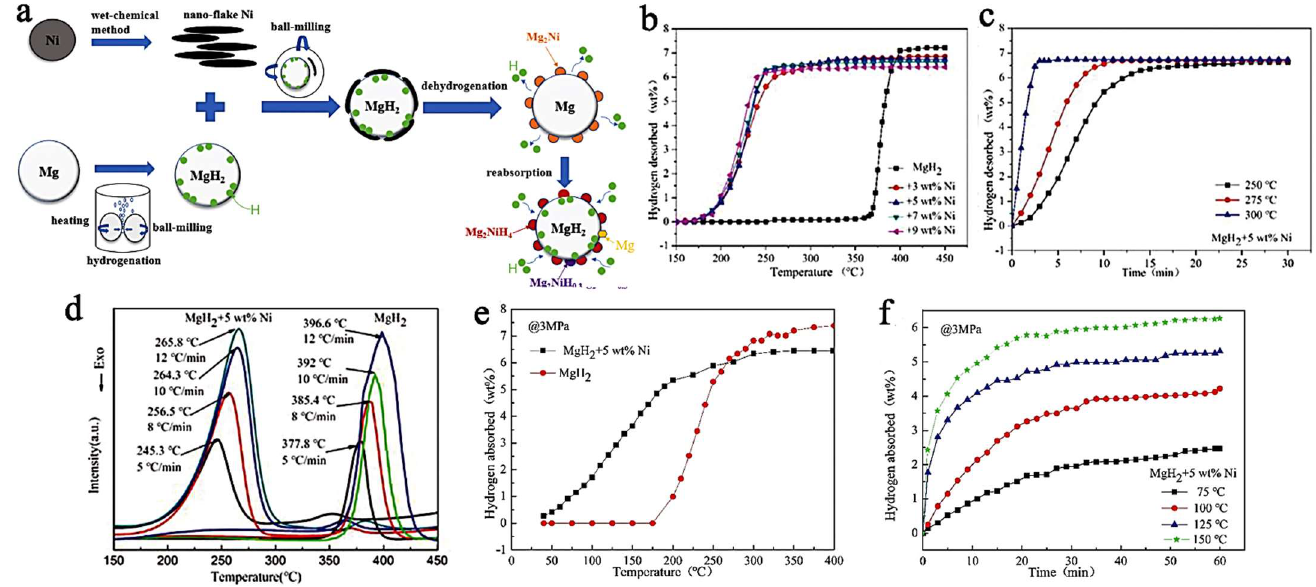
Figure 10. Preparation and reaction evolution in the MgH 2 +Ni composite ( a ); the rising temperature dehydrogenation curve ( b ); Isothermal dehydrogenation curves of MgH 2 + 5 wt.% Ni at different temperatures ( c ); DSC curves of MgH 2 + 5 wt.% Ni at different rates of increasing temperature ( d ); Non-isothermal hydrogenation curves of MgH 2 with and without 5 wt.% Ni ( e ); Isothermal hydrogen absorption curves at different temperatures of MgH 2 + 5 wt.% Ni ( f ). Reprinted/adapted with permission from Ref. [202]. 2021, Royal Society of Chemistry.